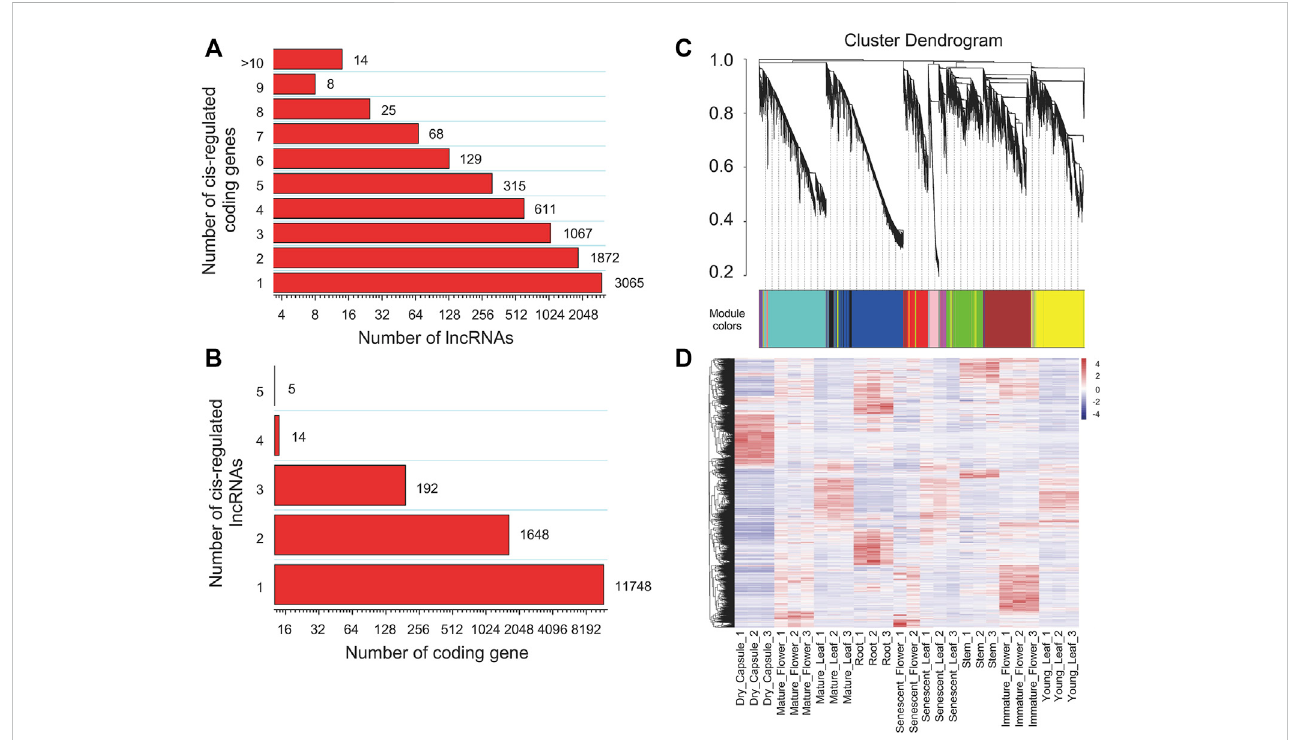
FIGURE 4 InteractionstatisticsoflncRNAsandtheirtargetprotein-codinggenesintobacco. (A) Thenumberoftargetprotein-codinggenesregulatedbylncRNAs, (B) The number of lncRNAs that have potential trans-regulatory effects on protein-coding genes, (C) Clustering dendrograms of lncRNAs and their tans- regulated targets, with dissimilarity based on the topological overlap, together with assigned module colours, (D) Hierarchical cluster of expression for lncRNAs in different tissues.